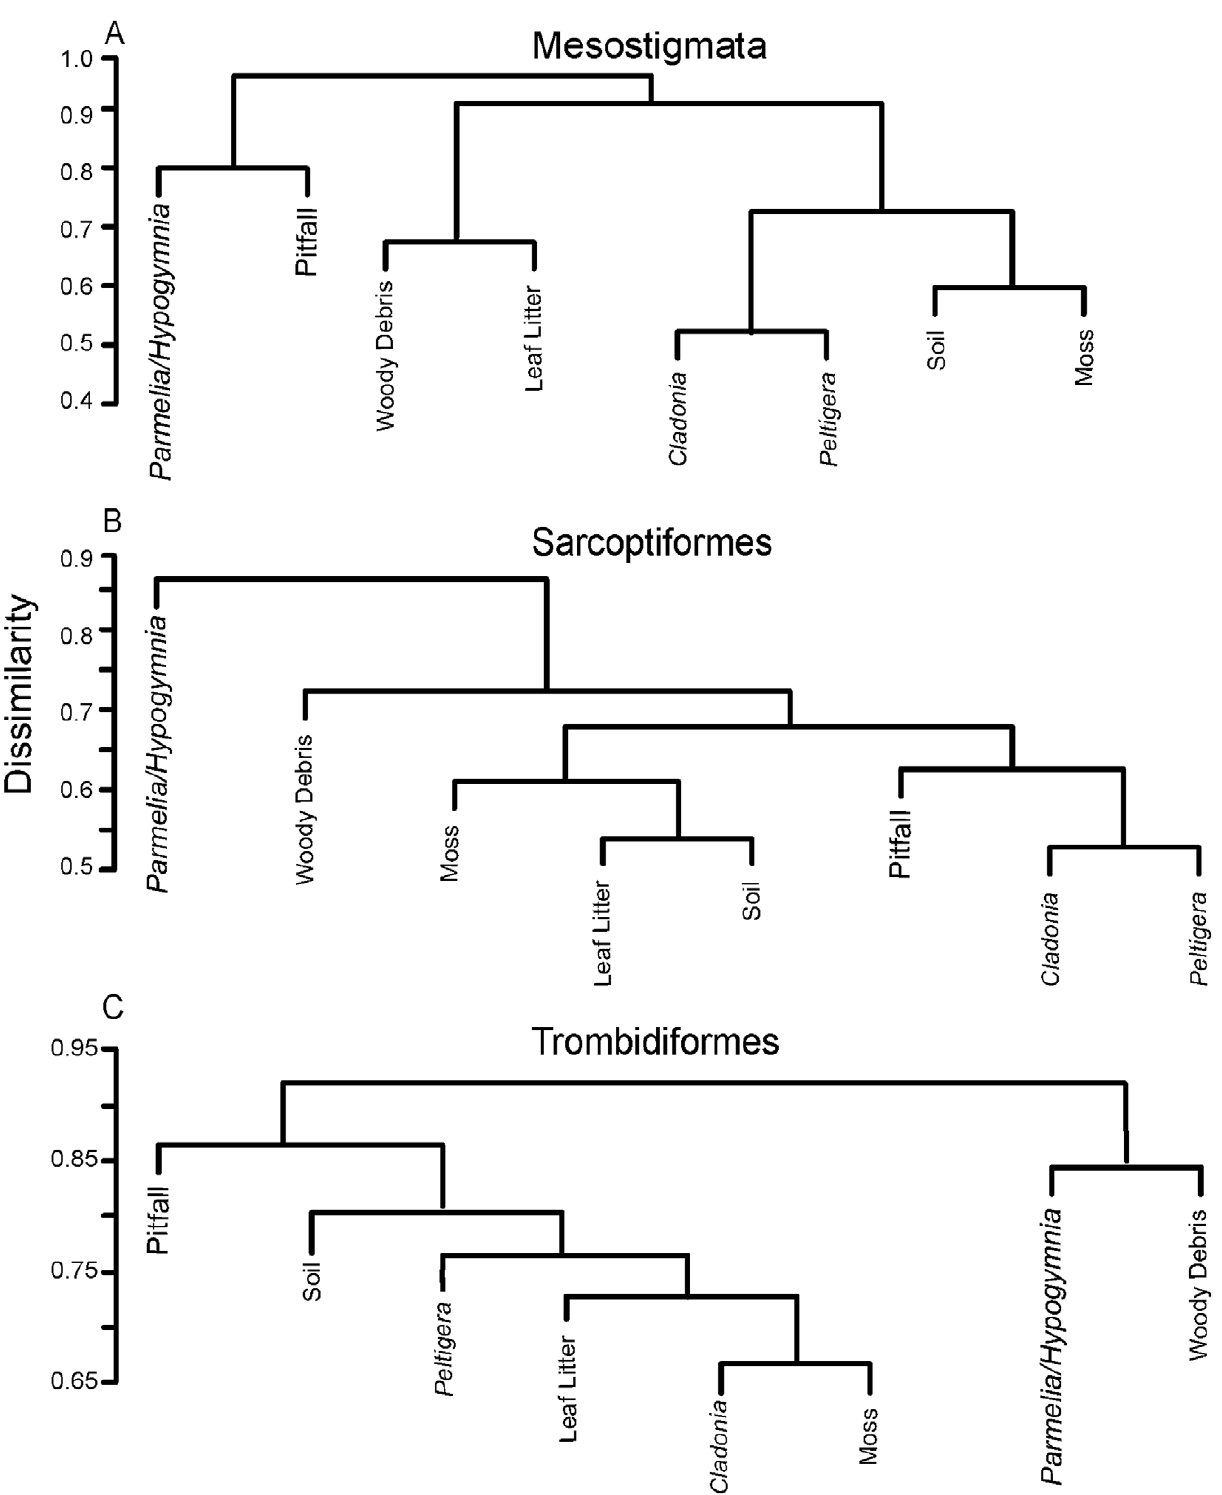
Figure 4. Cluster dendrograms of showing the similarity of species assemblages for three mite orders among 8 substrates. doi:10.1371/journal.pone.0048755.g004 sexes, revealing a mite fauna with a species richness rivalling the most diverse of temperate habitats. Our work has also indicated the value of supplementing systematic sampling designs with